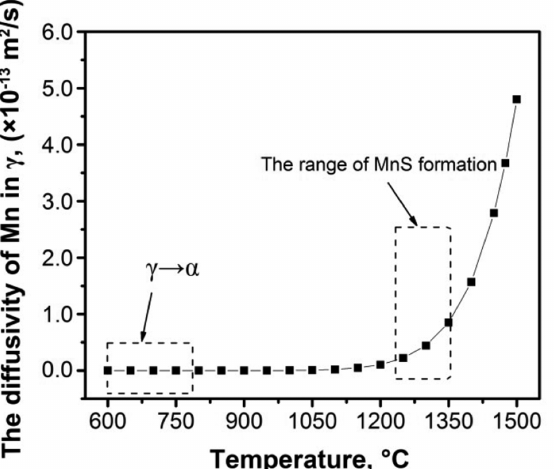
Figure 10: The diffusion coefficient of Mn elements in austenite at different